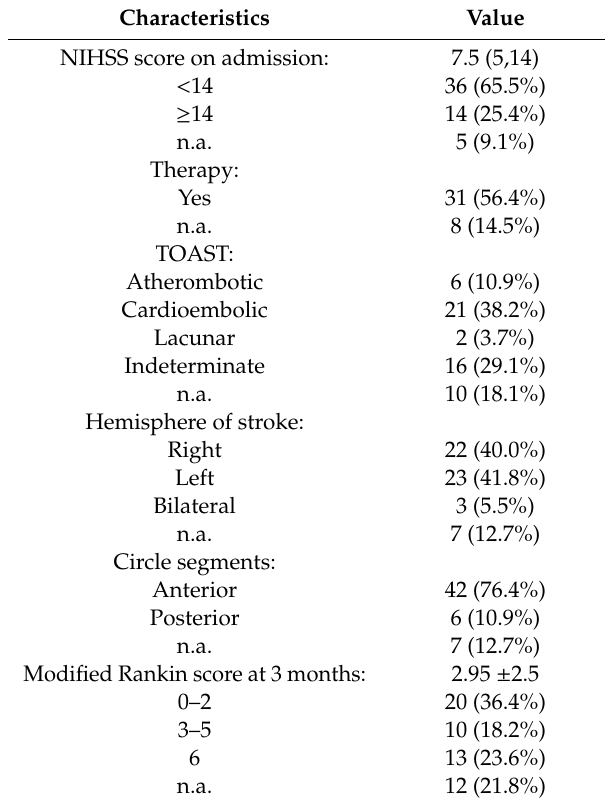
Table 2. Clinical features of acute ischemic stroke ( n =